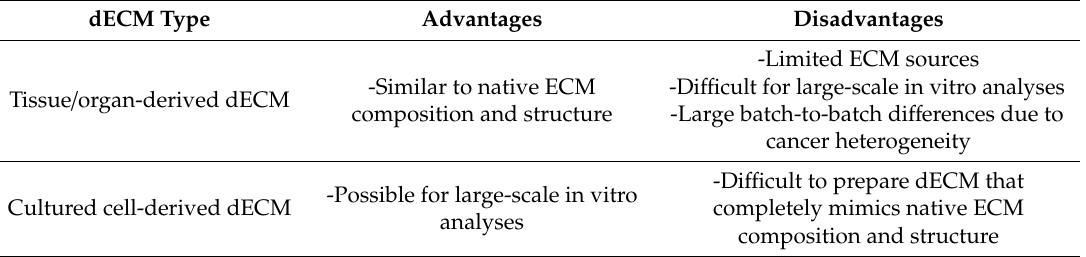
Table 1. Comparison of decellularized extracellular matrix (dECM) sources for cancer research. dECM